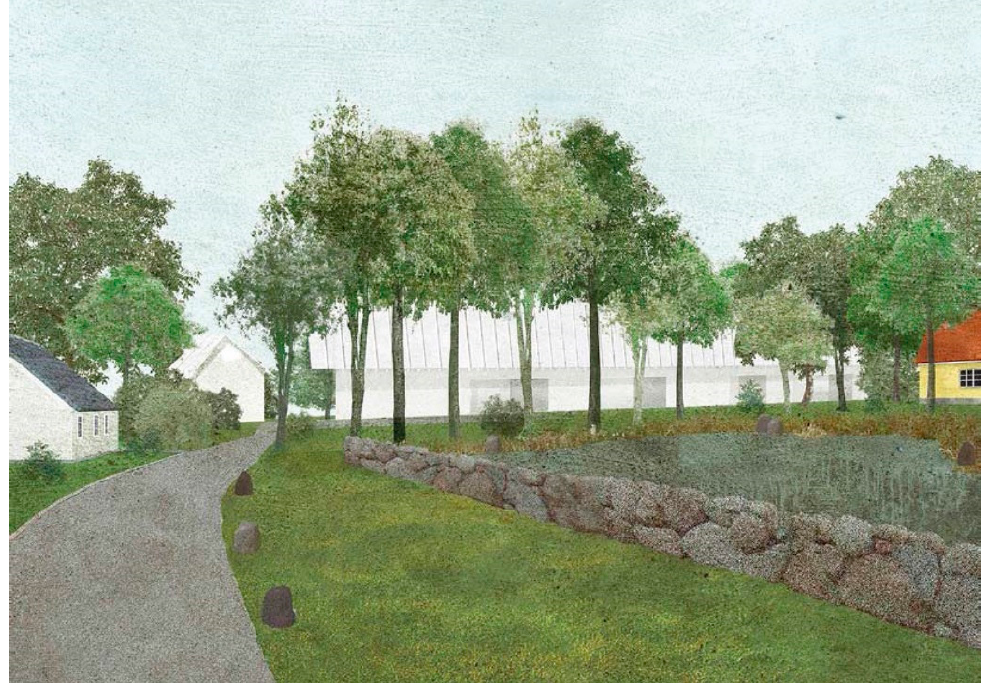
Figure 7. View to the production unit from the main street of Høve with the village pond to the right. The main production unit appears as the large white structure behind the trees. Across the road is the visitor centre and the farm shop.